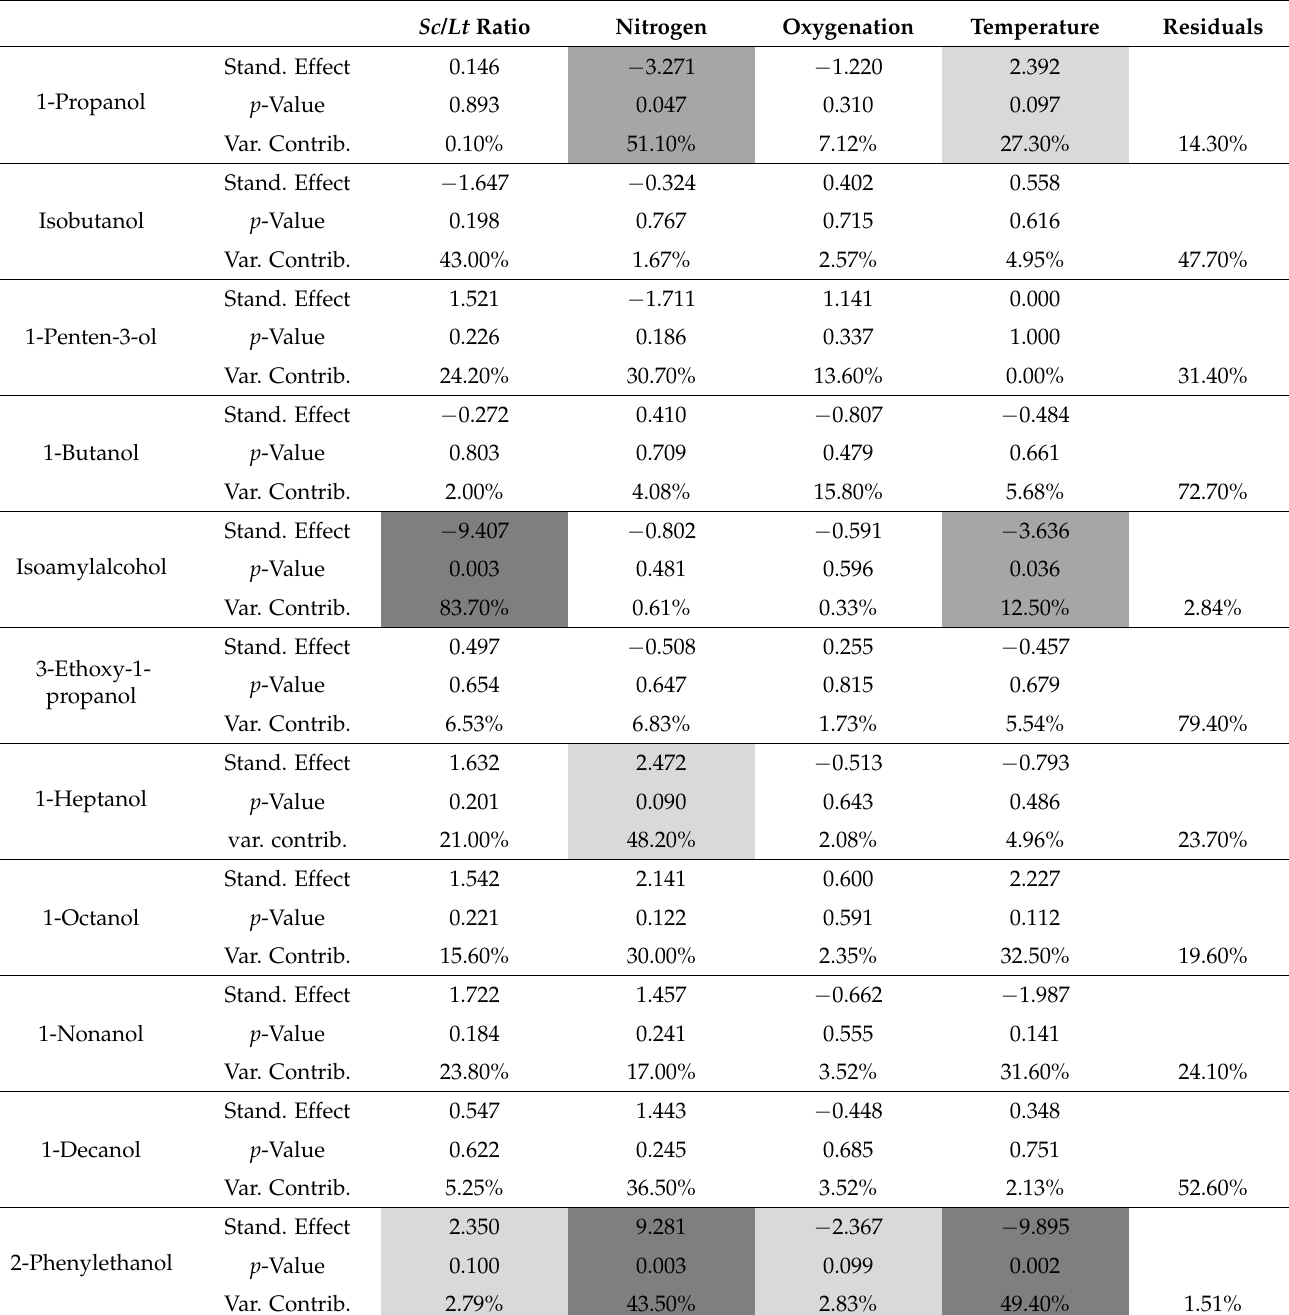
Table 6. Impact of fermentation parameters on the production of different volatile